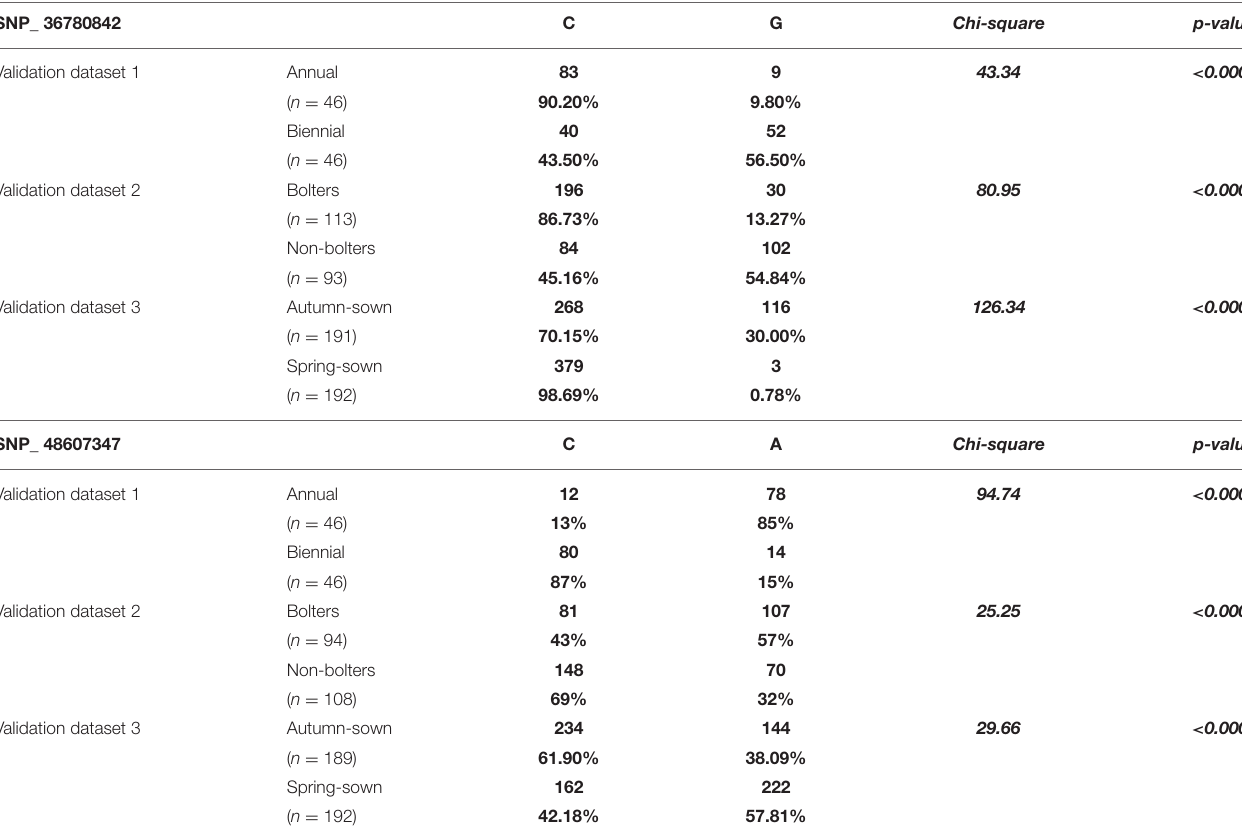
TABLE 2 | Contingency table based on rhAmp genotyping of SNP_36780842 and SNP_48607347 at three levels—annual vs. biennial beets, bolters and non-bolters of the biennial beets, and autumn-sown and spring-sown